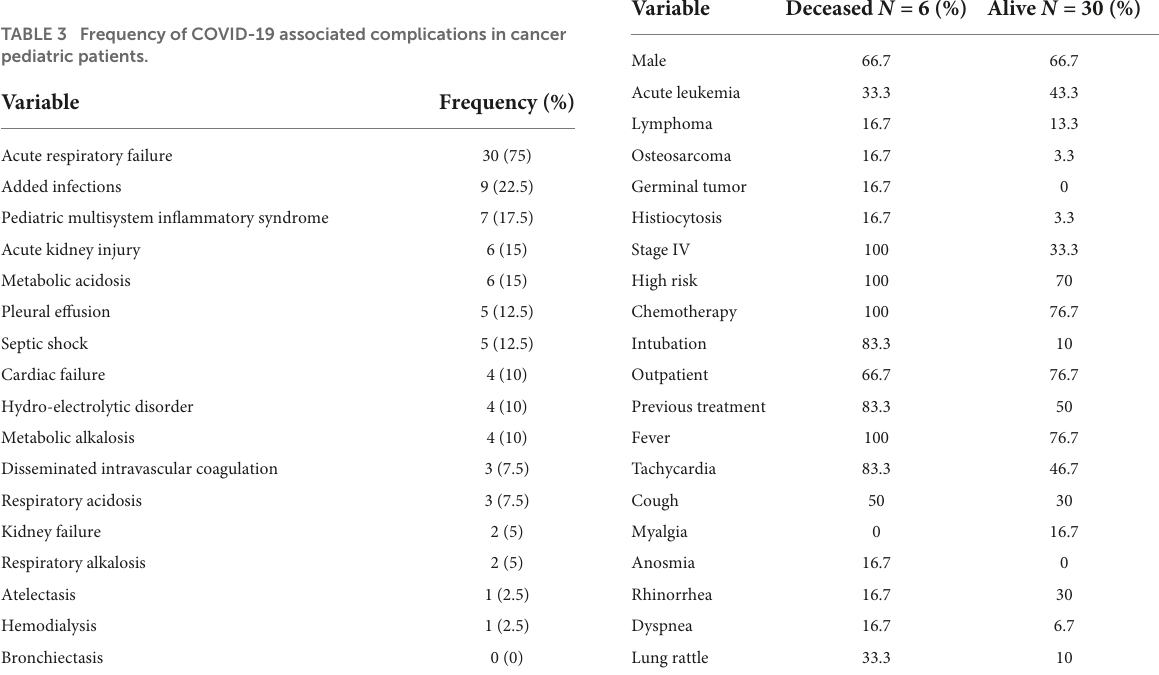
TABLE 4 Mortality-associated clinical factors